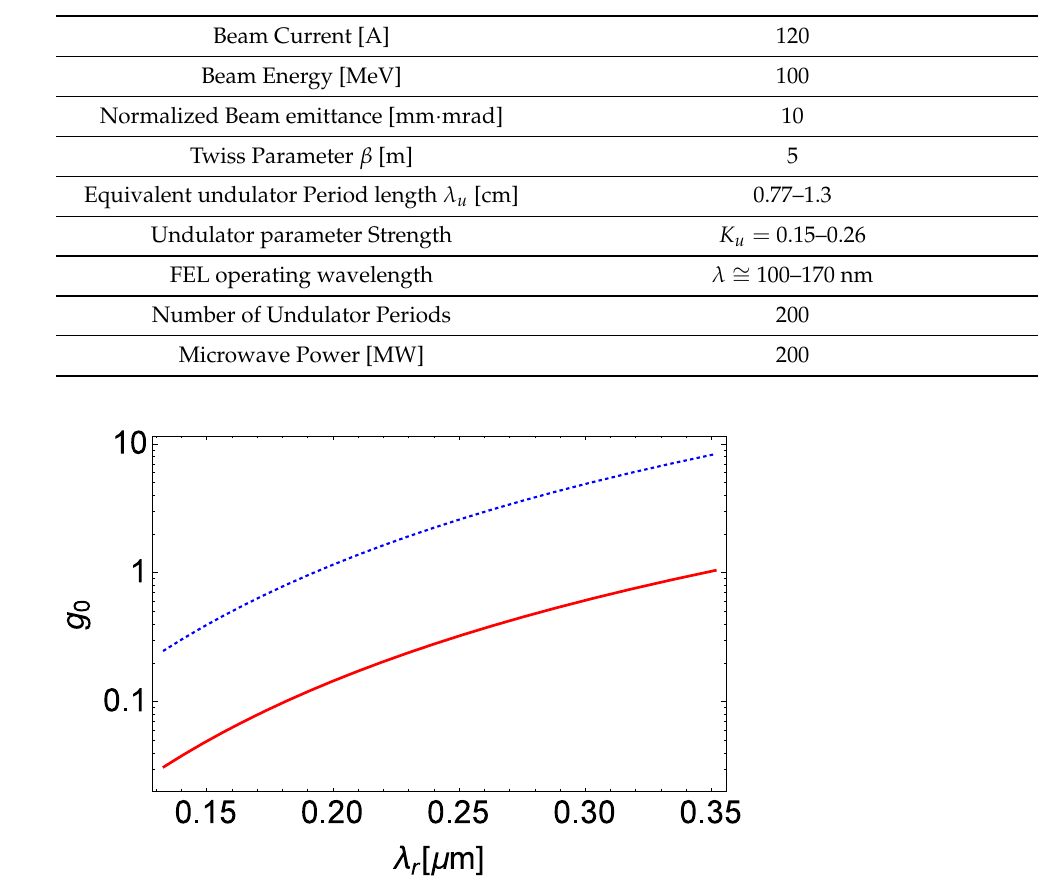
Figure 8. Small signal gain coefficient vs. resonant wavelength for values of RF Power = 200 MW, γ = 200 and N u = 100 (continuous line) and N u = 200